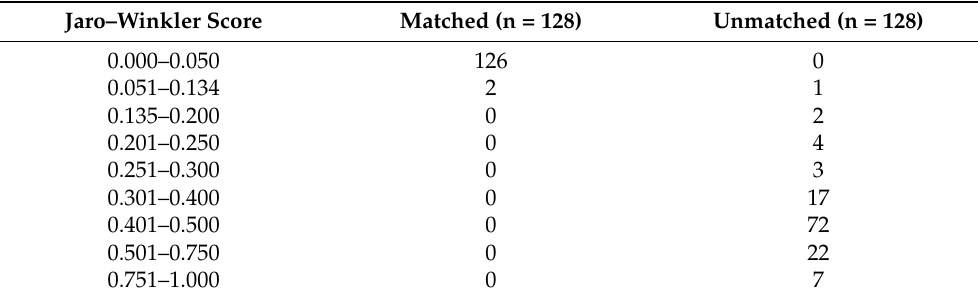
Table 2. Distribution of the Jaro–Winkler distance of matched and unmatched pairs that met the socio-demographic